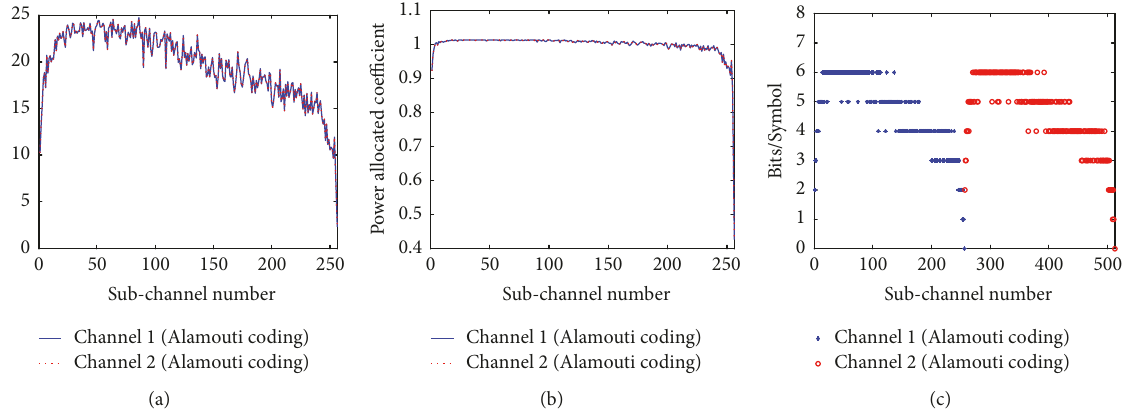
Figure 6: Power and bit allocation results for Alamouti coding system ( K =5.4985, 𝐵𝐸𝑅 T =0.003).